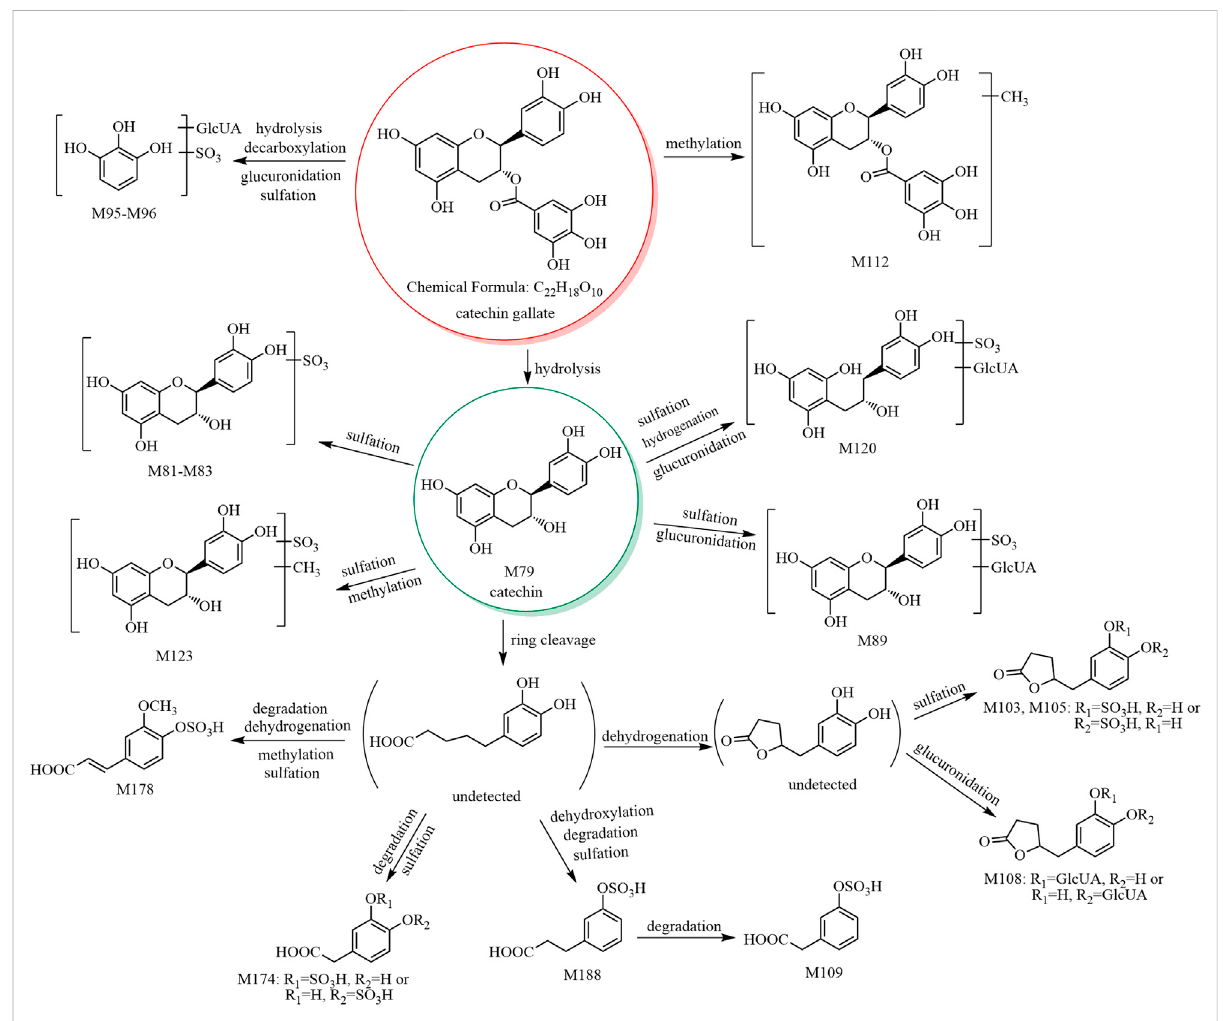
FIGURE 2 The 17 metabolites (all new) and proposed metabolic pathways of catechin gallate in mice.